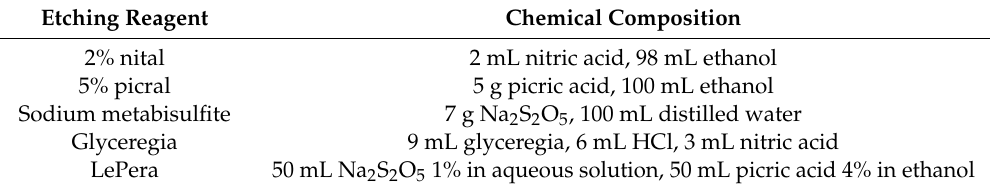
Table 2. Various chemical reagents used to reveal the microstructural features of Q&B heat-treated samples.